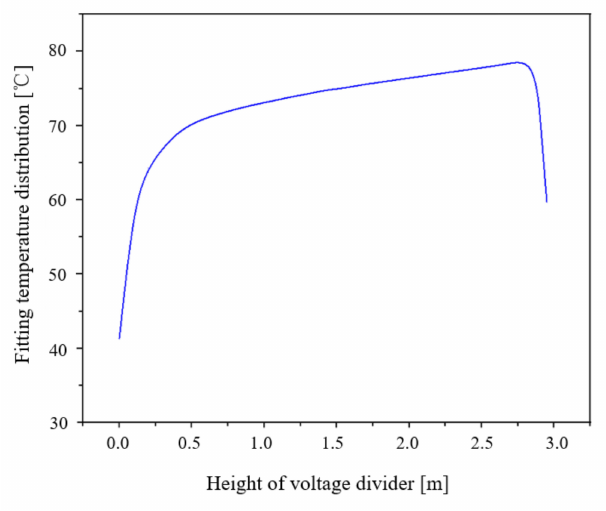
Figure 6. Steady-state temperature distribution at the axis of the voltage divider